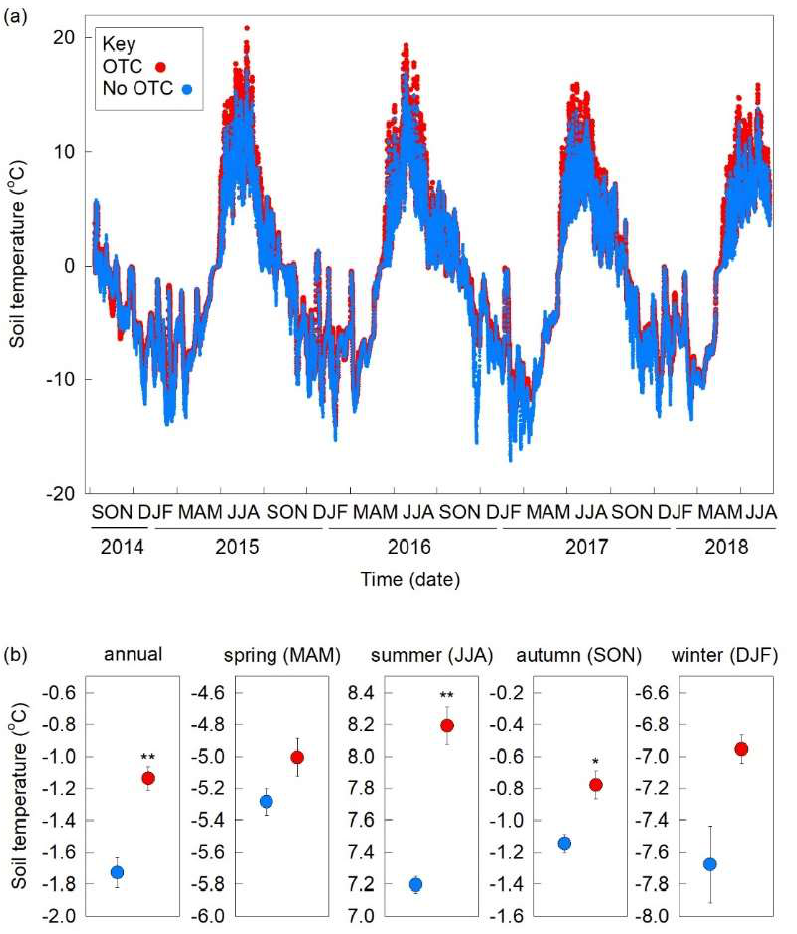
Figure 2. ( a ) Soil temperatures recorded hourly at 30–35 mm depth in unchambered and chambered plots between September 2014 and August 2018. Values are means of four measurements, except those for unchambered plots between September 2017 and August 2018, which are means of two measurements. See key for treatment notation. ( b ) Mean annual and seasonal soil temperatures measured at 30–35 mm depth in unchambered and chambered plots. Values are means of four replicates ± SEM. Differences between each pair of values are denoted by * p < 0.05 and ** p < 0.01. Treatment notation as in ( a ). Note that y -axes are identically scaled.